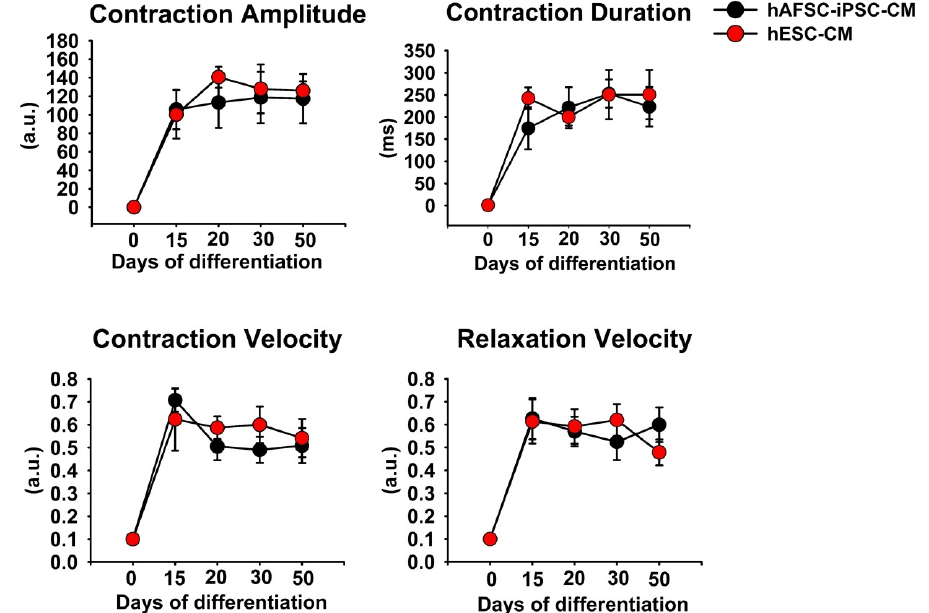
Figure 2. Analyzing in vitro contractile performance of human amniotic fluid-derived stem cells-induced pluripotent stem cell-derived cardiomyocyte (hAFSC-iPSC-CM) and human embryonic stem cell-derived cardiomyocyte (hESC-CM). An automated non-profit software, MUSCLEMOTION, was used to quantitate the in vitro contractile performance. There were no significant differences in contractile function (including contraction amplitude, duration, and velocity) and relaxation of all the data points between these hAFSC-iPSC-CMs and hESC-CMs. Each data point represents the mean ± S.E.M. ( n = 5).